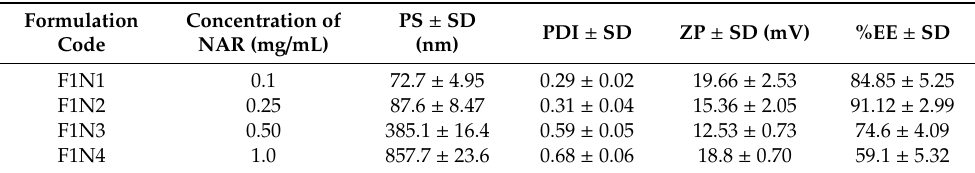
Table 2. E ff ect of increase in naringenin concentration on particle size, polydispersity index, zeta potential, and entrapment e ffi